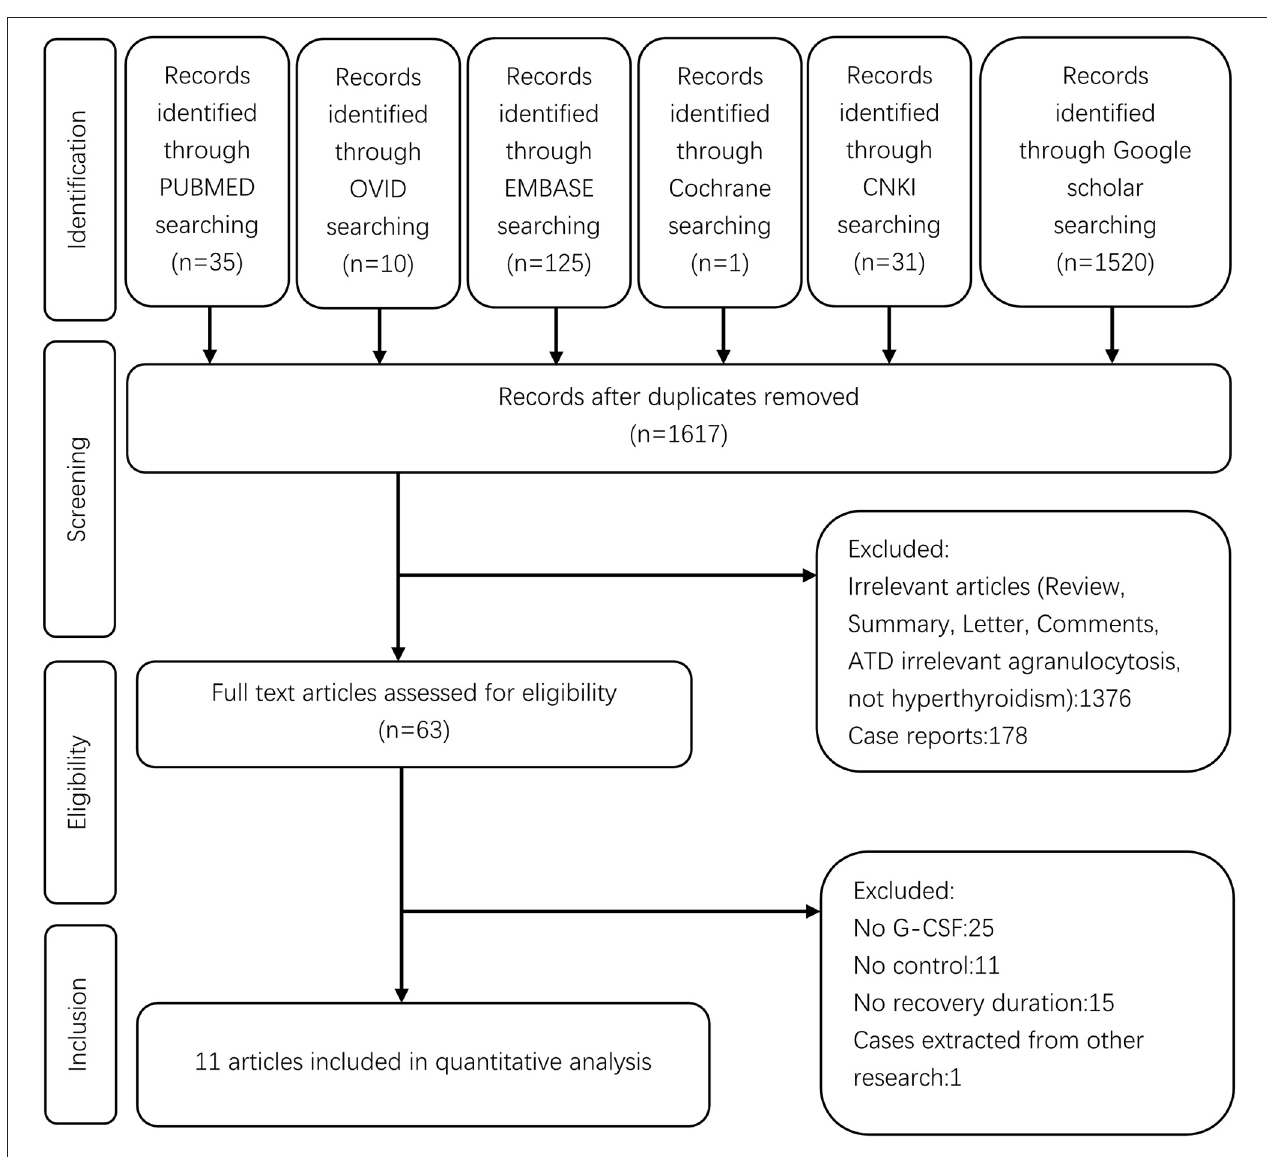
FIGURE 1 | Flow diagram of the search